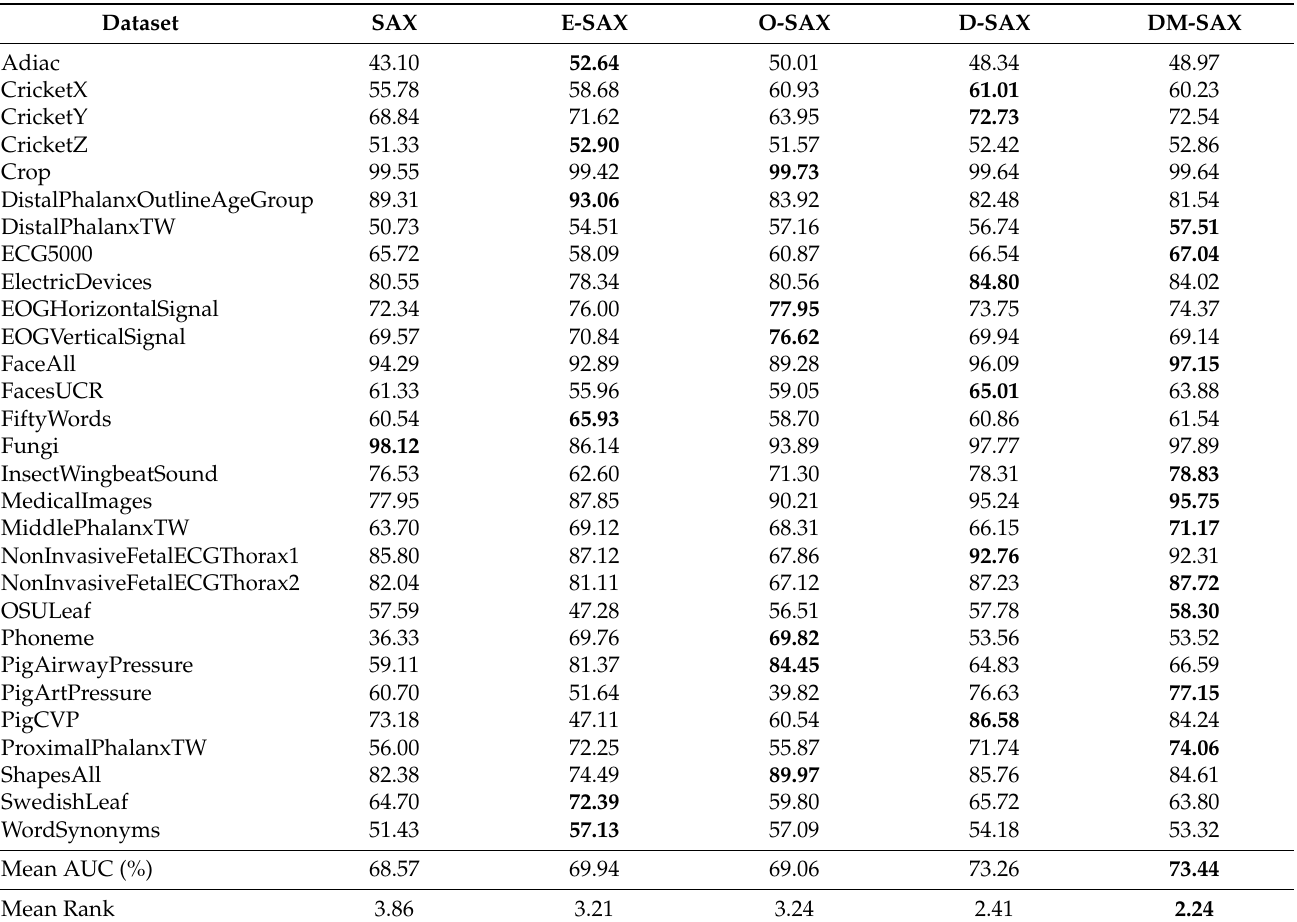
Table 3. Performance benchmarks (UCR datasets).